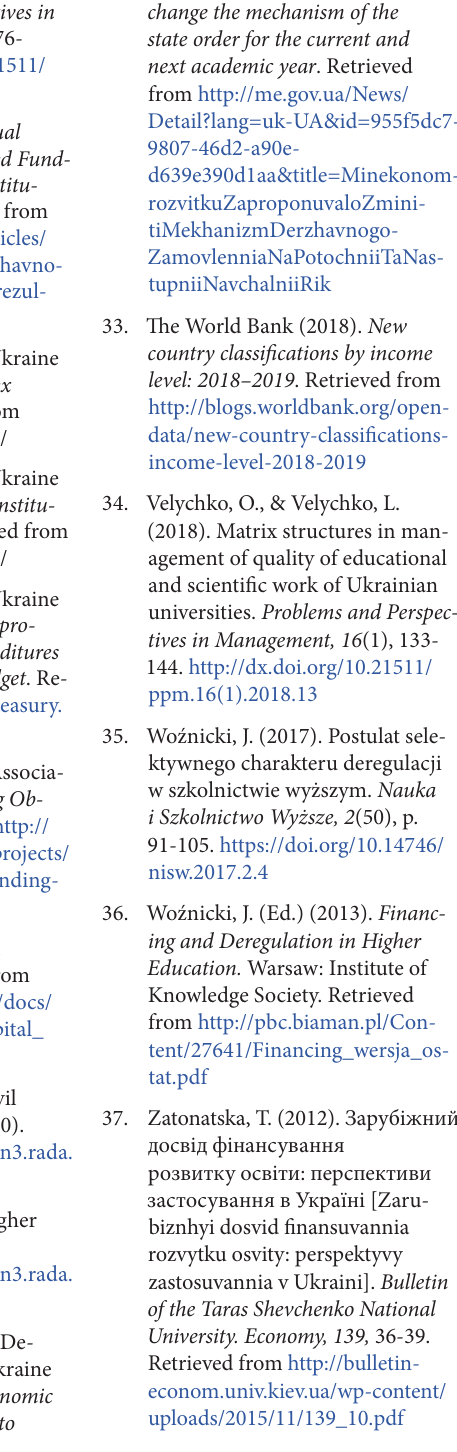
розвитку освіти: